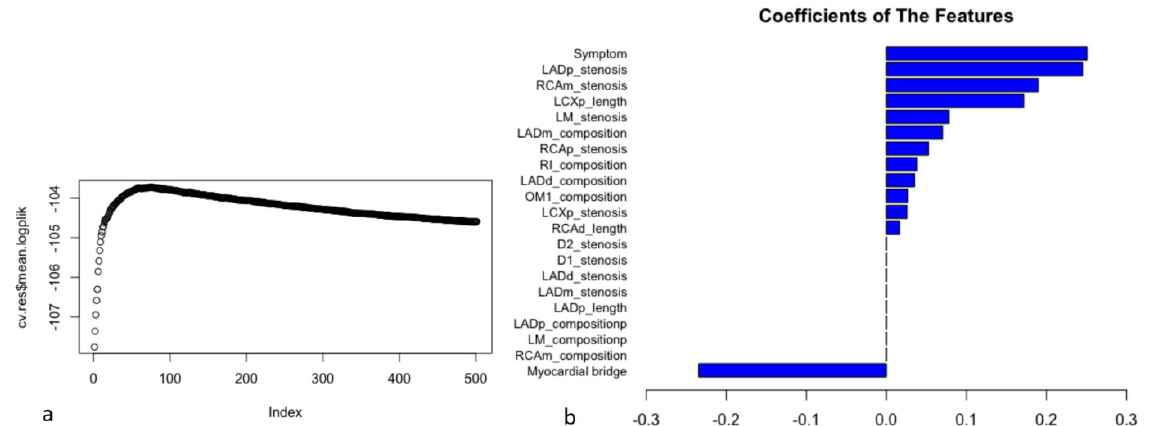
Figure 3. The process of model construction and coefficients of the features in the ML model. Filtered CCTA variables were included in model generation. The 21 filtered variables with non-zero coefficients in the results of LASSO-COX were included in ML model generation. The hyperparameters of ML model were automatically calculated on the training dataset. After tuning the hyperparameters (the penalty was 1116, and the step was 74) from 10-fold stratified cross validation, the model was refitted on the entire training dataset for training model. When the logplik of the 10-fold stratified cross validation was the largest (cv.res$mean.logplik = − 103.723), it showed the optimal model in the training dataset and the coefficients of features ( a ). In the ML model, chest symptoms (symptom), the stenosis severity of the proximal anterior descending branch (LADp_stenosis), and the stenosis severity of the middle right coronary artery (RCAm_stenosis) were among the top three variables (coefficients: 0.251, 0.245, and 0.190, respectively) ( b ).